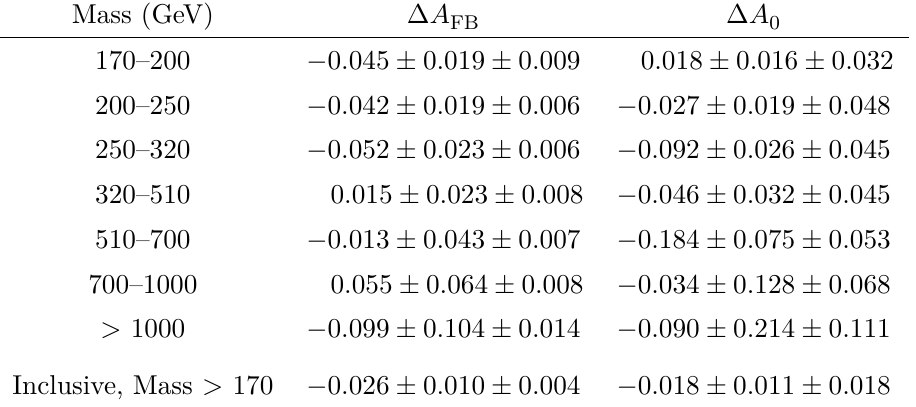
and ∆ A between the muon and electron channels FB 0